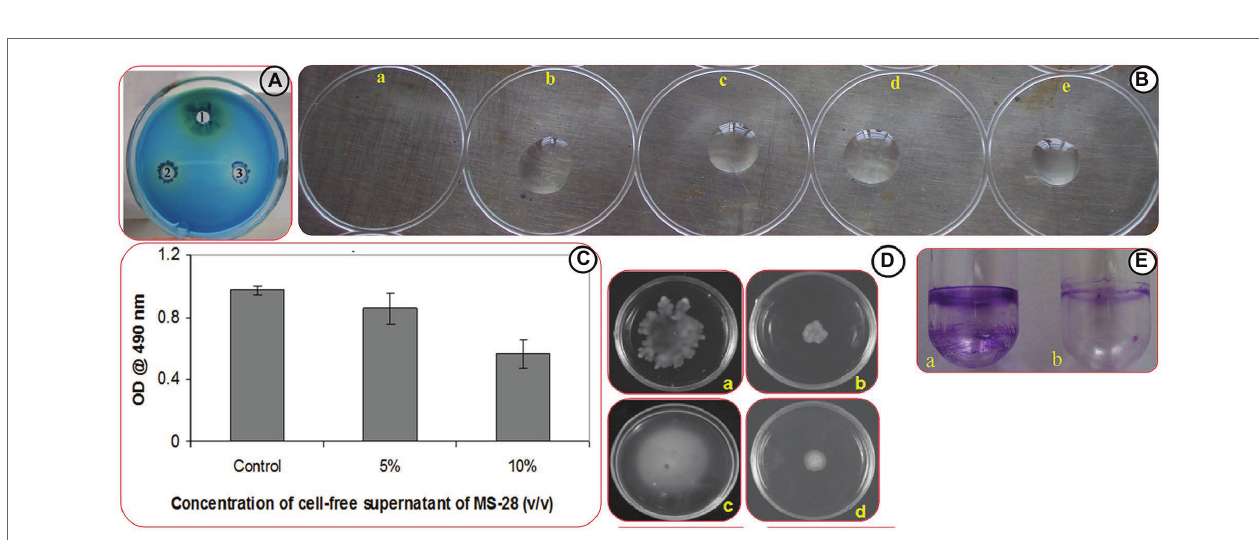
FIGURE 1 | Confocal microscopy images of bacterial biofilms harbored with and without Psychrobacter sp. CFS (200 μ l/ml). Images represent the untreated controls (insert-C) and Psychrobacter sp. treated (insert-T) biofilms of PAO1 (A) , S. marcescens (B) , V. vulnificus (C) , and V. parahaemolyticus (D)